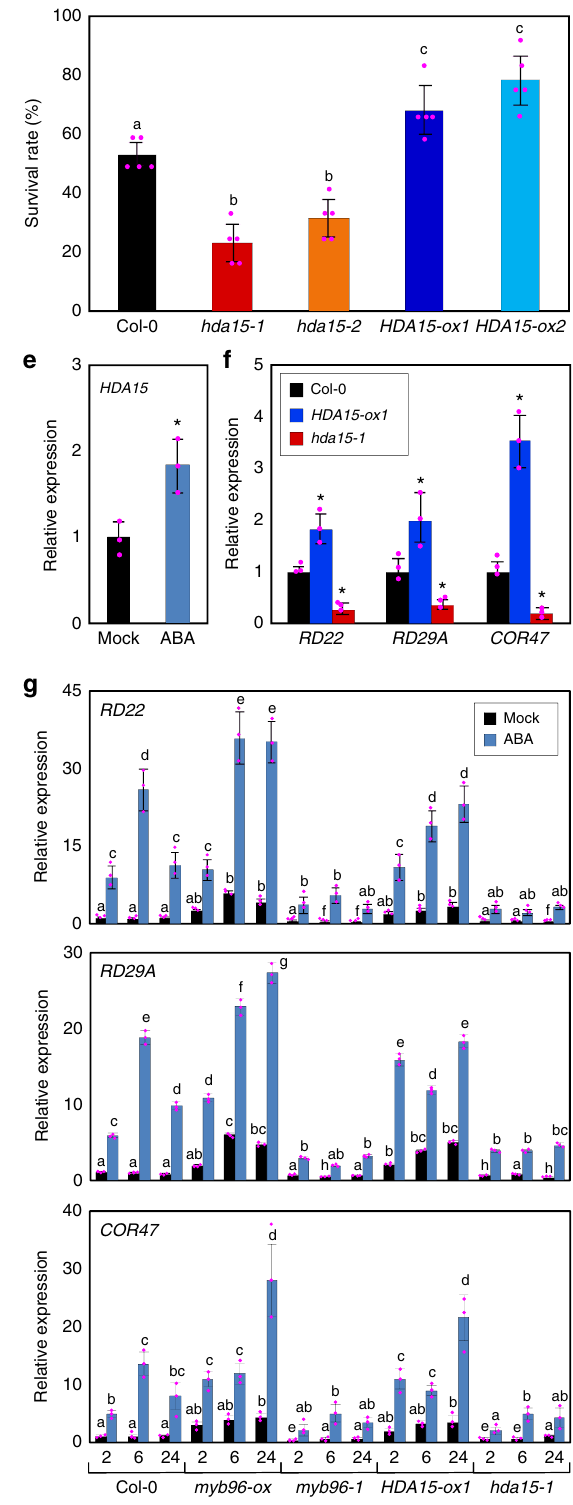
fi rst examined whether the physical interaction between MYB96 and HDA15 is affected by ABA. pMYB96:MYB96-MYC x pHDA15:HDA15-GFP transgenic Arabidopsis plants were gener- ated and used for Co-IP assays. Co-IP followed by immunoblot analysis revealed that MYB96 and HDA15 form a complex, and interaction was further enhanced as ABA concentration increases